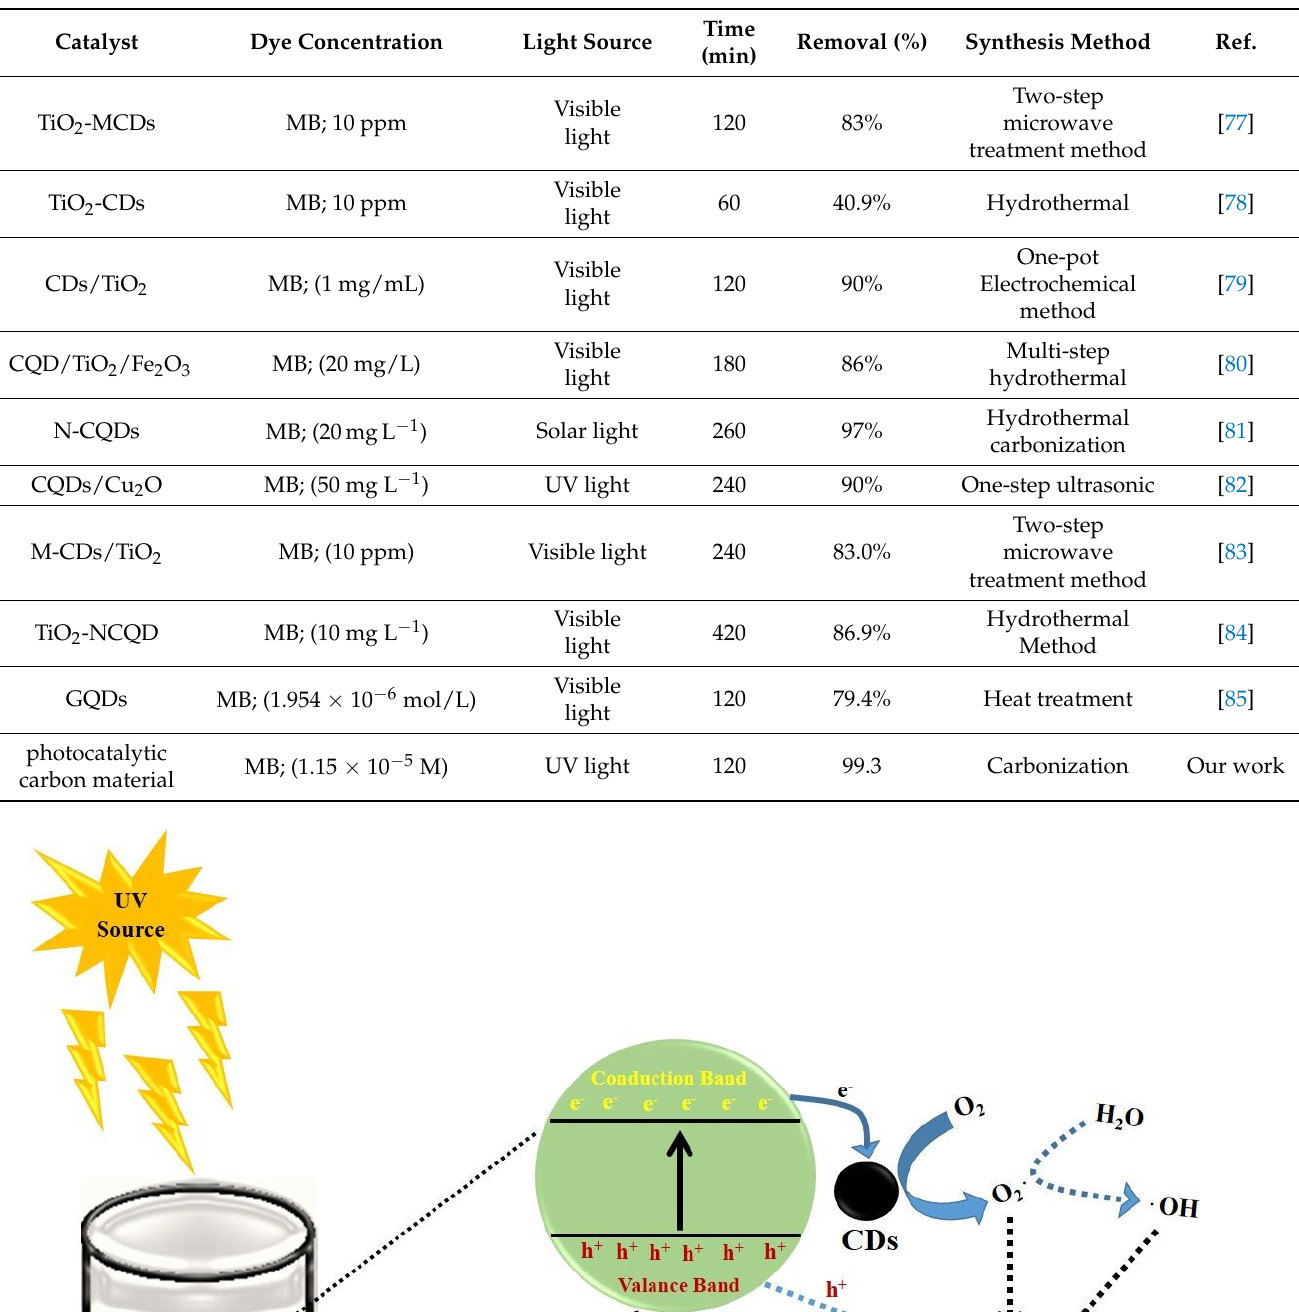
Table 2. Comparative results of the proposed study with the published analyzed data on